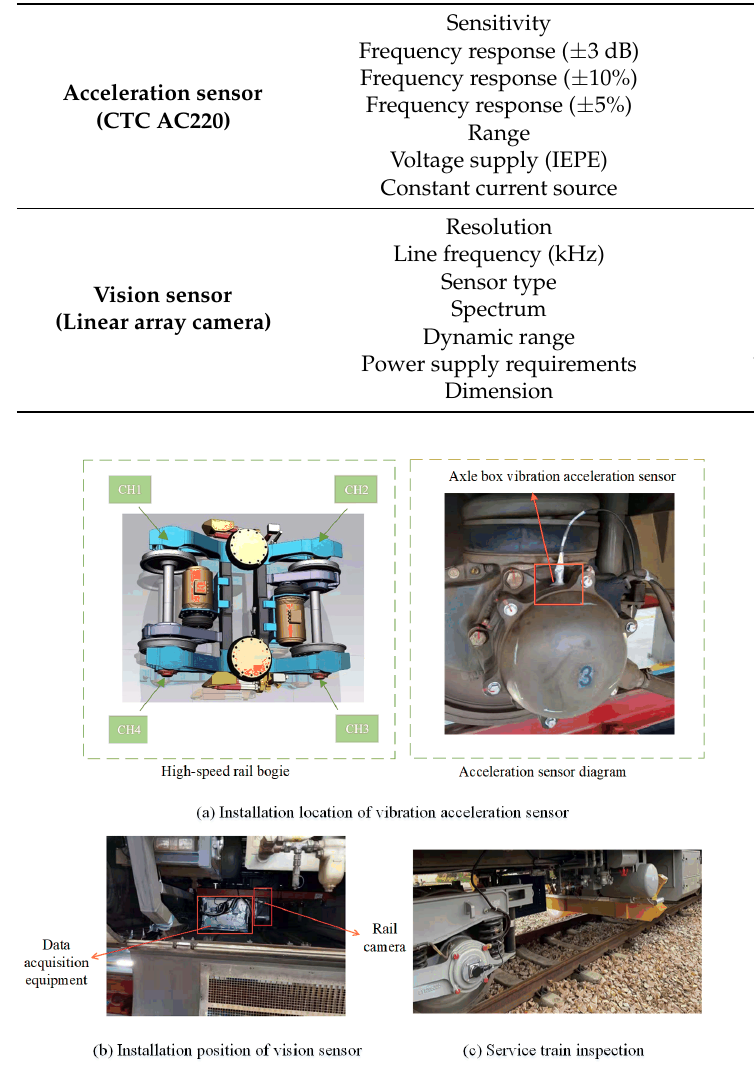
Figure 4. Installation position of test equipment and sensors.